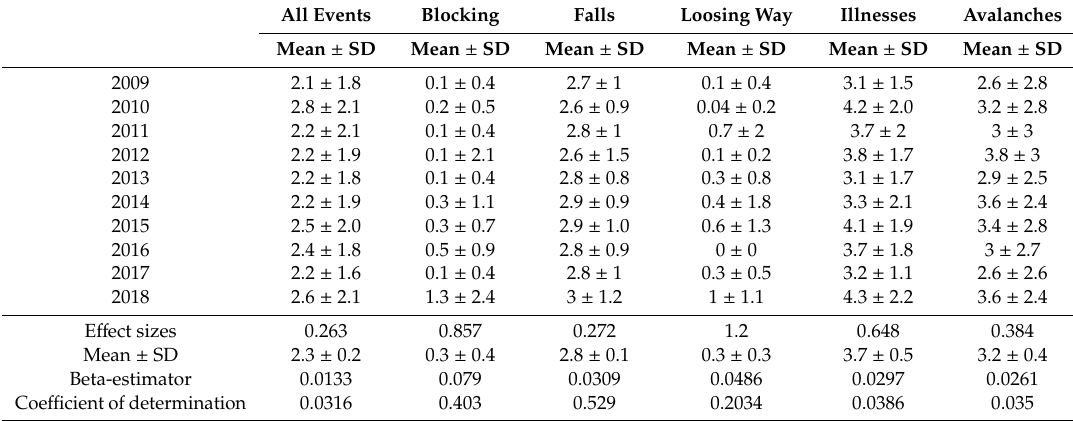
Table 3. Average NACA Scores over the whole period